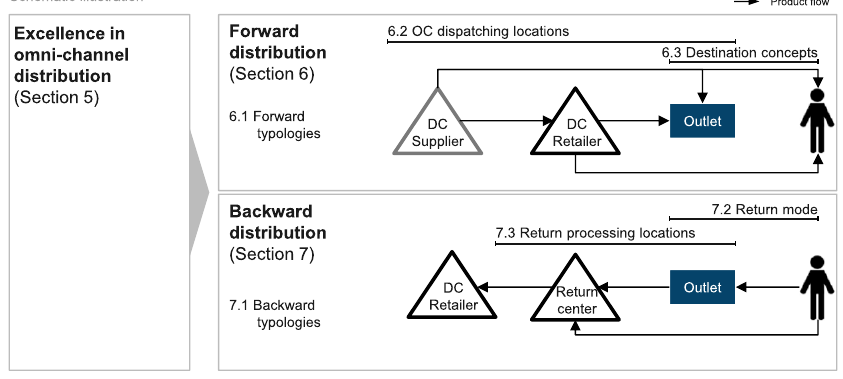
Fig. 1 Overview of areas in omni-channel forward and backward